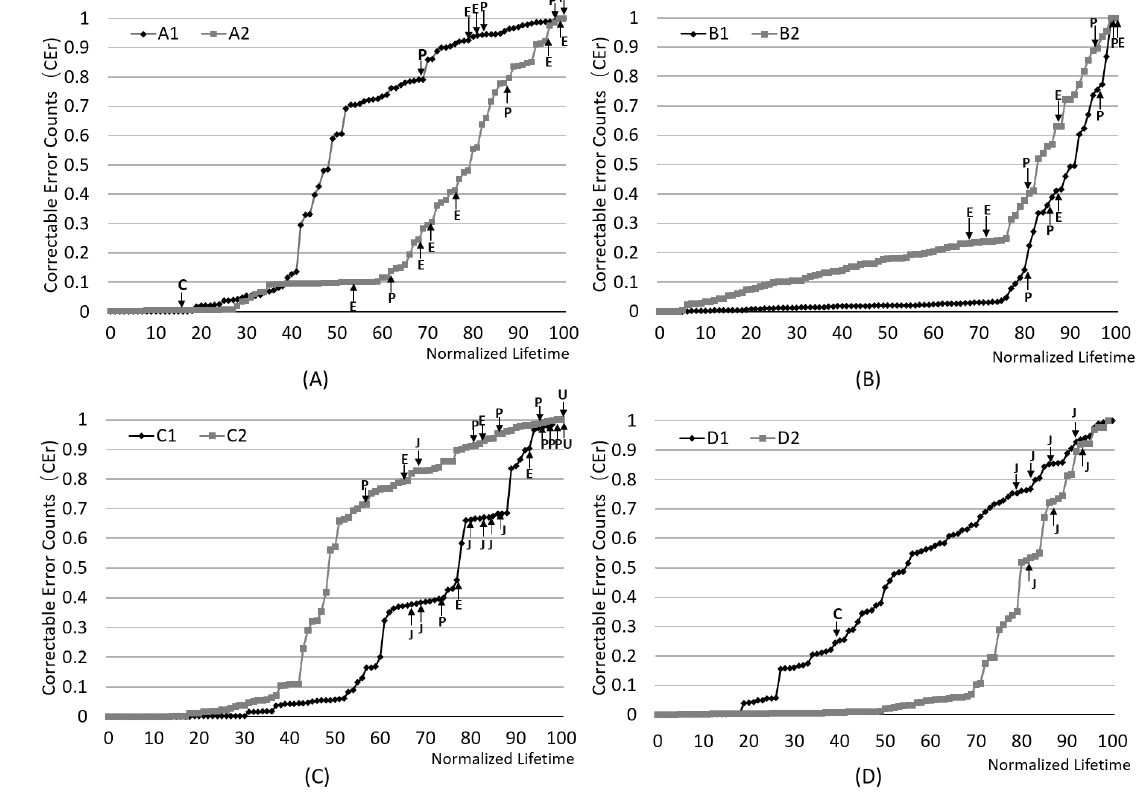
Figure 5. Trend of CEr during the whole lifetime of eight drives (e.g., A1 and A2 in ( A )). P and E mean the surging of Program errors and Erase errors, respectively. U indicates the occurrence of Uncorrectable error. J and C correspondingly indicate the occurrence of performance Jitter and CRC